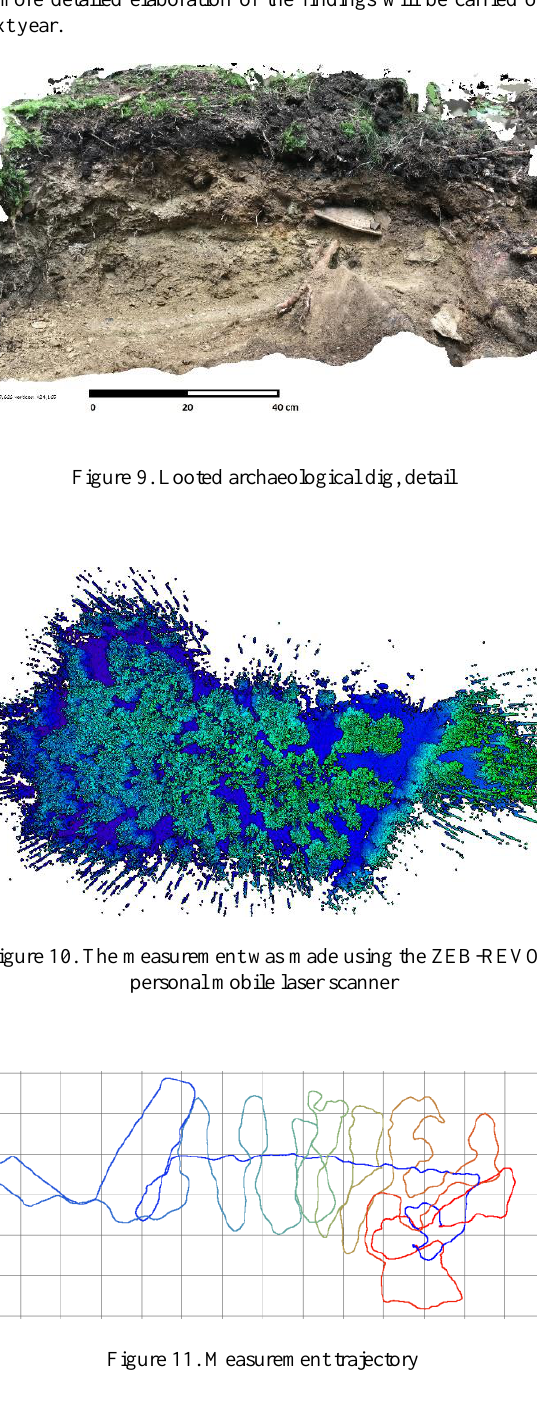
Figure 8. Looted archaeological dig, the 3D model, Metashape